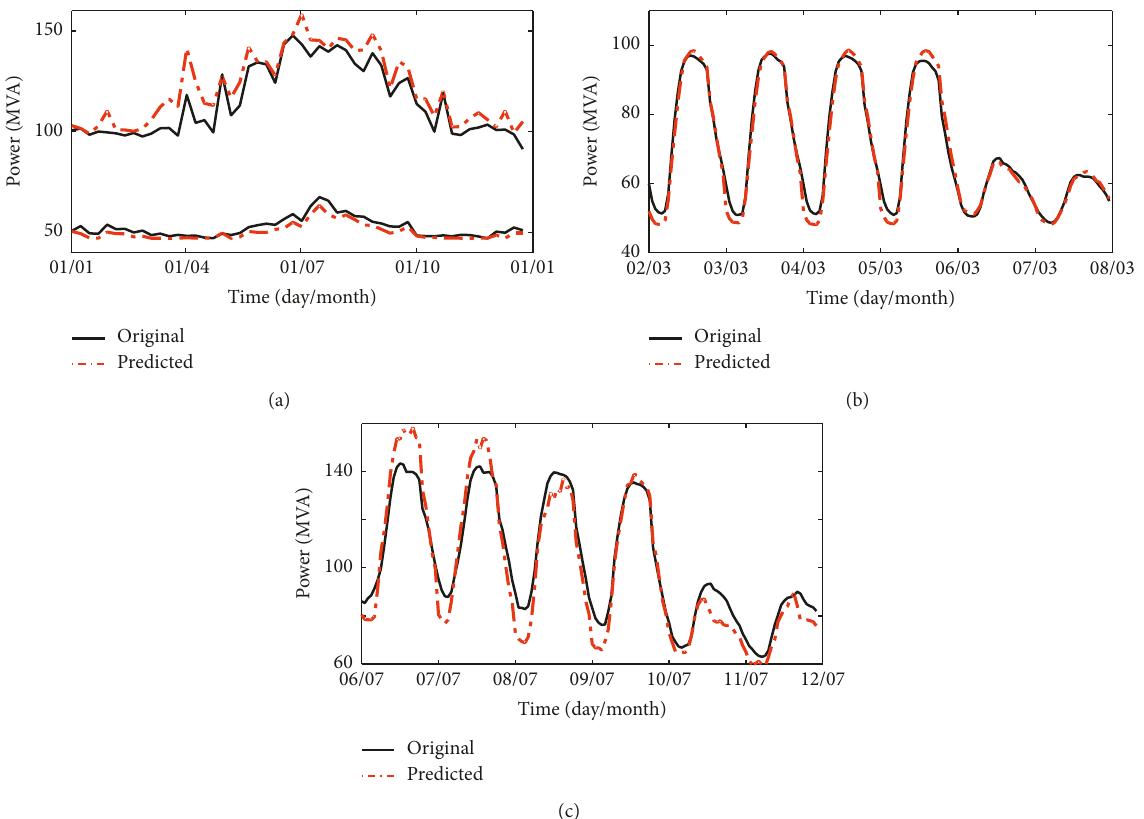
Figure 8: Comparison between the original load shapes and forecasted load shapes based on outdoor temperature: (a) envelope of the entire year; (b) valley; (c) peak.